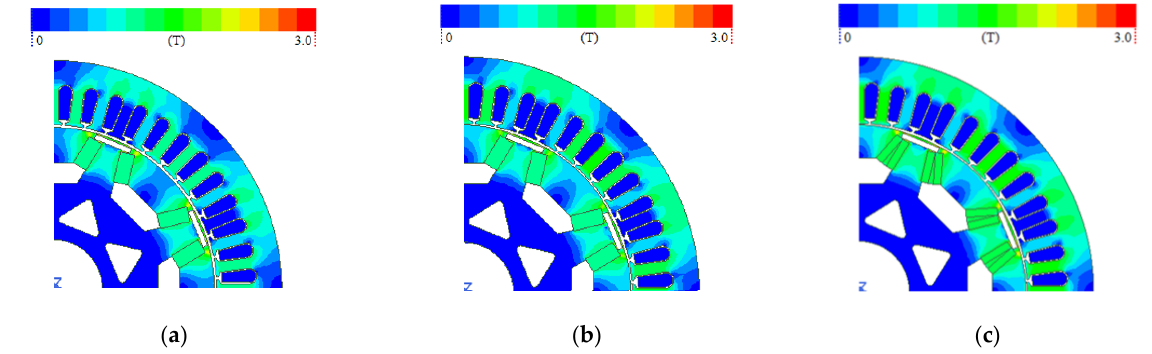
Figure 9. Comparison of magnetic flux density of three types of motors. ( a ) IPMSM; ( b ) IPMSMA; ( c ) IPMSMB. T is the unit of magnetic induction, that is, tesla.